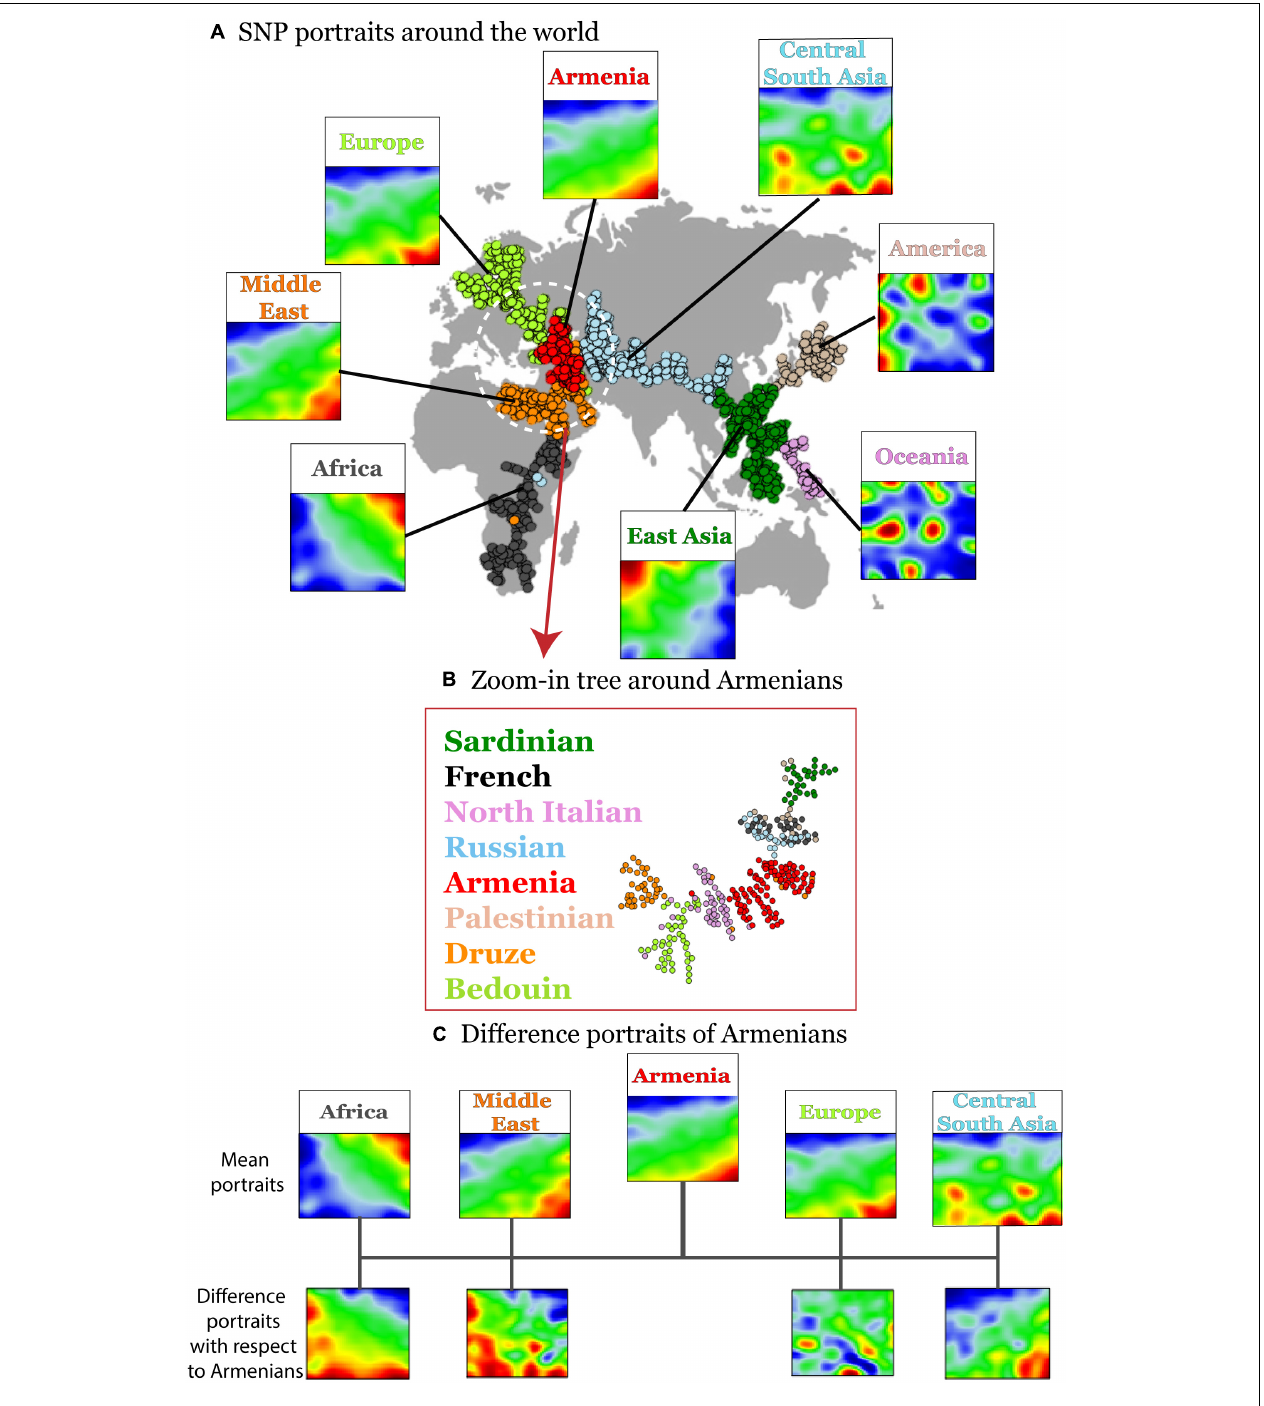
FIGURE 2 | Variation of disease-associated SNP portraits across geographic regions. (A) Mean SNP-portraits of seven geographic regions show systematic changes of their spot patterns. A minimum spanning tree (MST) was calculated using Pearson’s correlation coefficient between the SOM portraits of the individuals to visualize the similarity relations between their SNP-patterns. It is mapped on the geographic map to illustrate the relation between the genetic drift and the geographic distribution of the populations. Each circle refers to one individual. Their colors assign the respective geographic region. Armenians (red) form a cluster at the crossroad between African, European, and Asian branches of the MST. (B) A zoom-in SOM was calculated using data of selected populations from Middle East, Europe and Armenians for SOM-training to better resolve local similarity relations. The zoom-in MST reveals a relative compact clusters of Armenians bordered by populations from Middle East and Europe, respectively. (C) Difference portraits of Armenians with respect to other populations show an increase of non-African genetic contributions with respect to Middle Eastern populations and increased European contributions with respect to Central and South Asian populations.